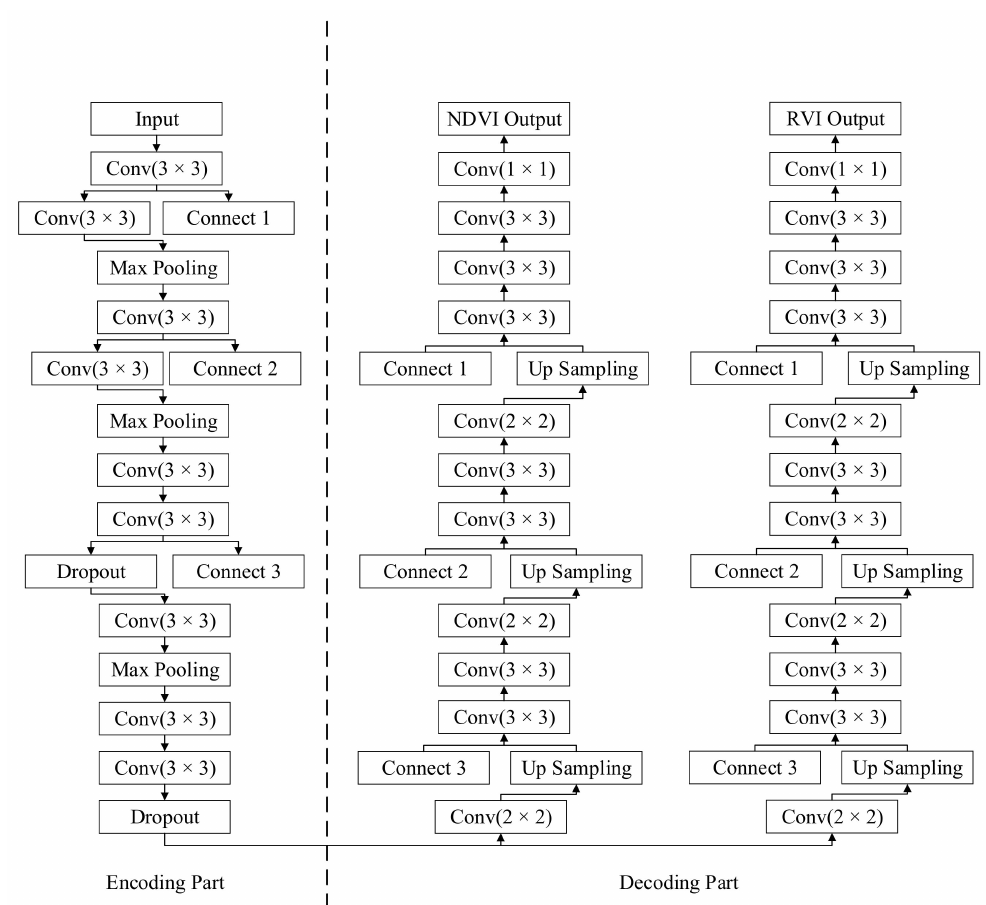
Figure 7. Unsupervised learning-based model for domain knowledge extraction. The function of the layer blocks are explained as follow: ‘Input’ represents an input layer; ‘Conv 3 × 3’ represents a convolutional layer with an kernel size of 3 × 3; ‘Max Pooling’ represents a max pooling layer; ‘Dropout’ represents a dropout layer for avoiding over-fitting; ‘Up Sampling’ represents an up sampling layer; ‘Connect’ represents the connection layer, the connection layer with the same number as connecting with each other; ‘Conv 2 × 2’ represents a convolutional layer with an kernel size of 2 × 2; ‘Conv 1 × 1’ represents a convolutional layer with an kernel size of 1 × 1; ‘NDVI Output’ represents an output layer that using normalized difference vegetation index (NDVI) as ground truth validation; ‘RVI Output’ represents an output layer that using ratio vegetation index (RVI) as ground truth